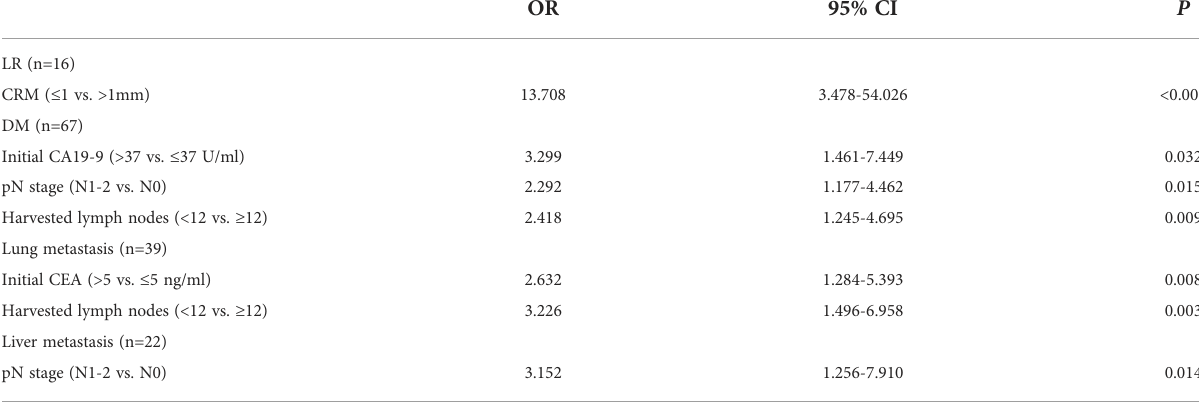
TABLE 4 Multivariate analyses of risk factors for local and distant